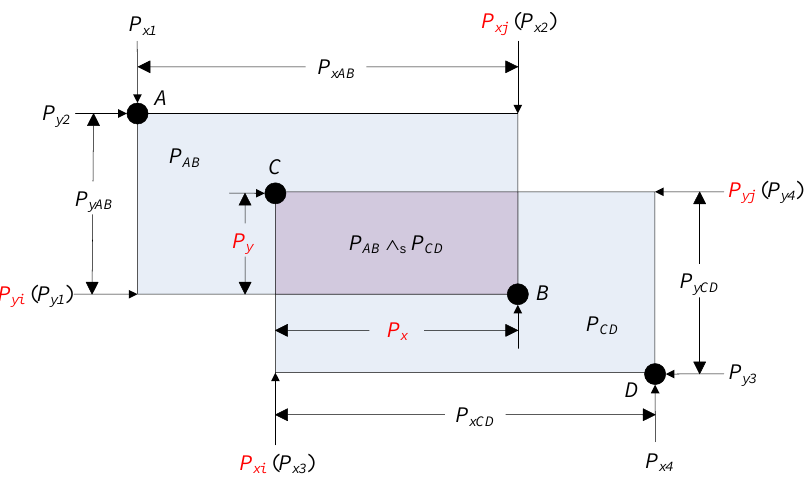
Figure 6. Spatial intersection operation.